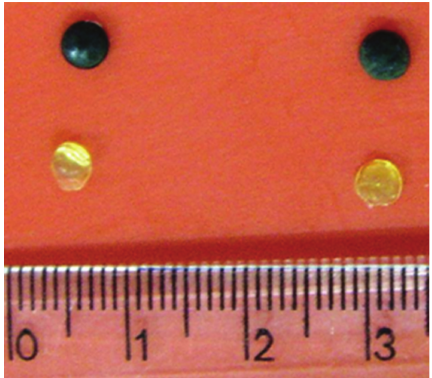
Figure 1: Disc of polyvinyl alcohol-glutaraldehyde-PVAG (yellow) and coated with polyaniline-PVAG-PANIG